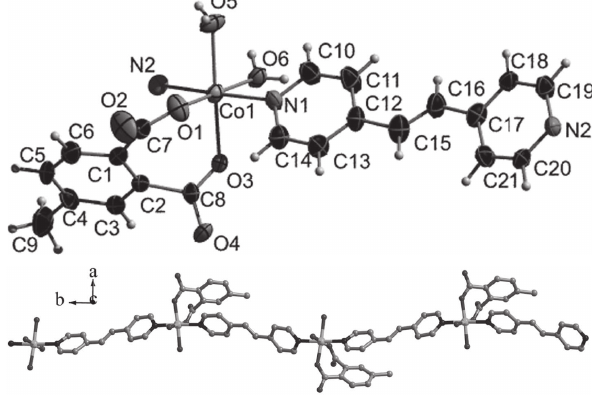
Table 1: Data collection and handling.